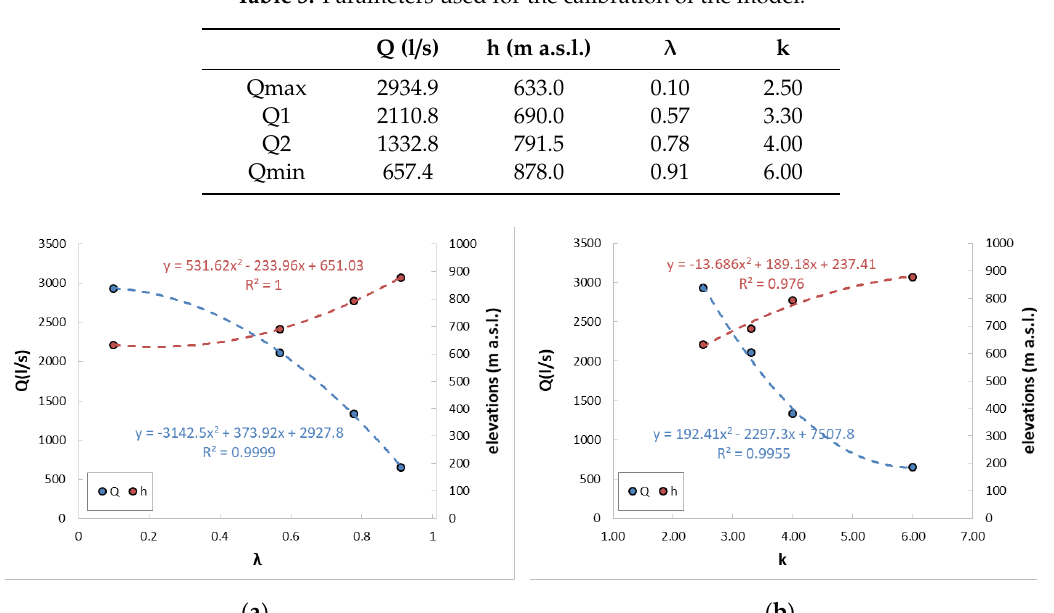
Table 3. Parameters used for the calibration of the model.